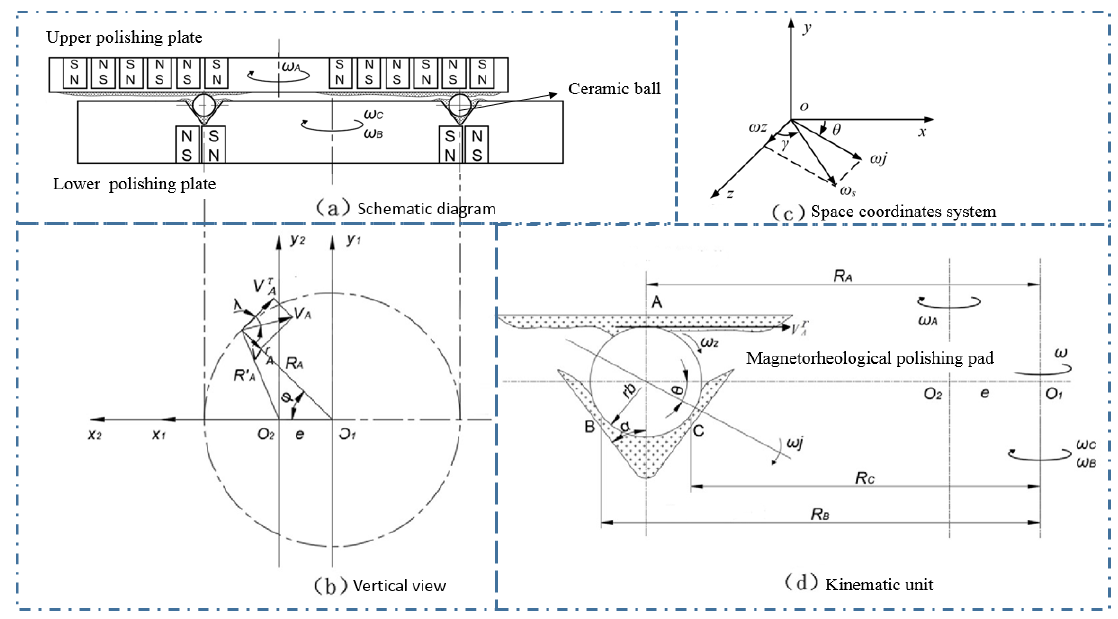
Figure 6. Schematic diagram of driving model of ceramic ball and finishing pad. ( a ) Schematic diagram. ( b ) Vertical view. ( c ) Space coordinates system. ( d ) Kinematic unit.